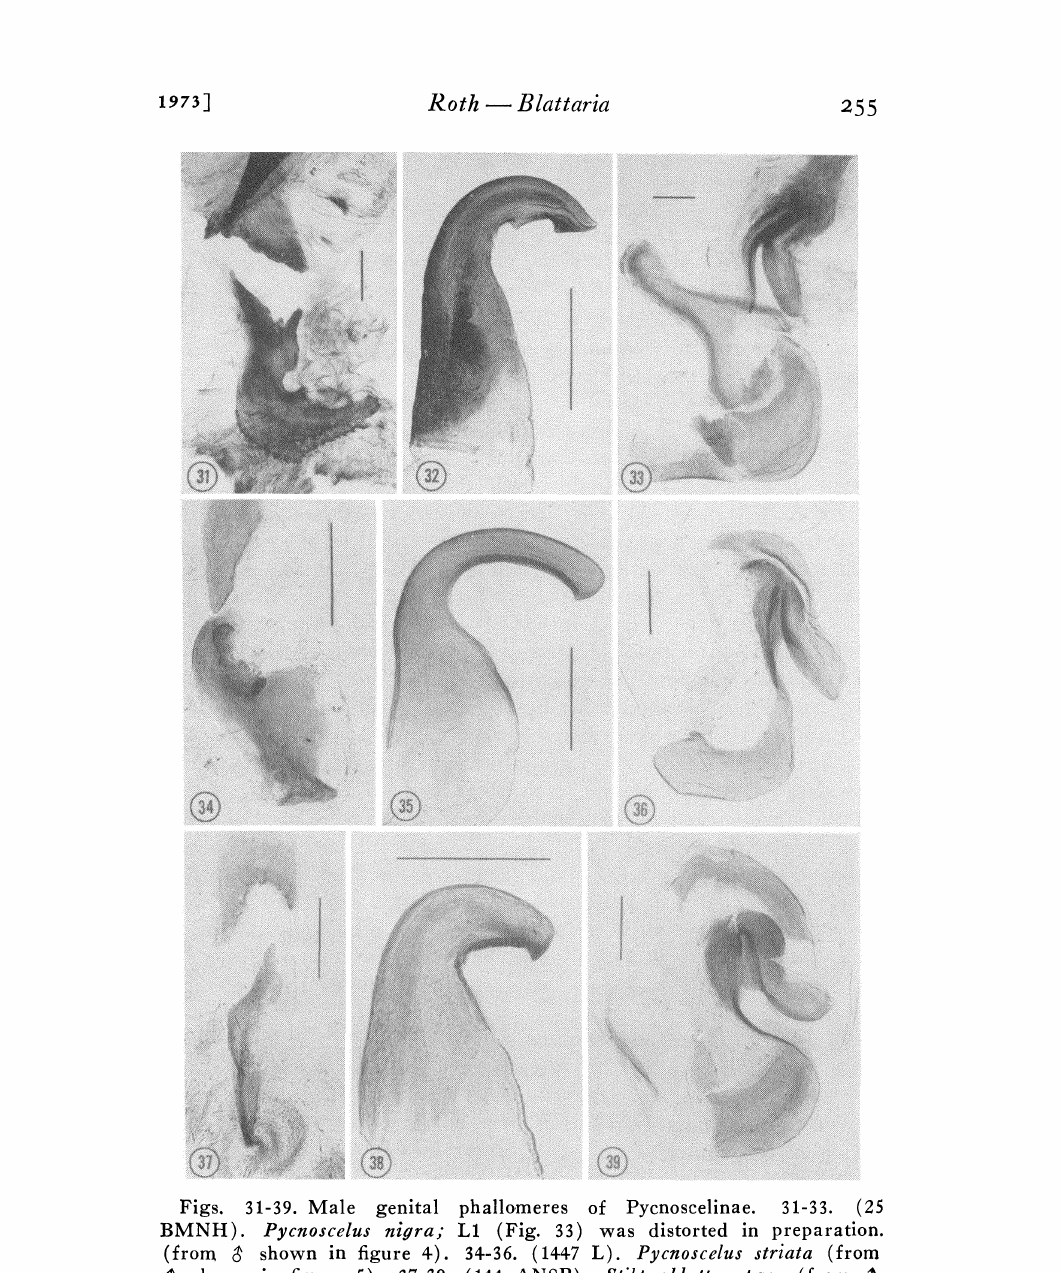
Figs. 31-39. Male genital phallomeres of Pycnoscelinae. 31-33. (25 BMNH). Pycnoscelus nigra; L1 (Fig. 33) was distorted in preparation. (from shown in figure 4). 34-36. (1447 L). Pycnoscelus striata (from shown in figure 5). 37-39. (144 ANSP). Stilpnoblatta opaca (from shown in figure 6). (scale 0.2